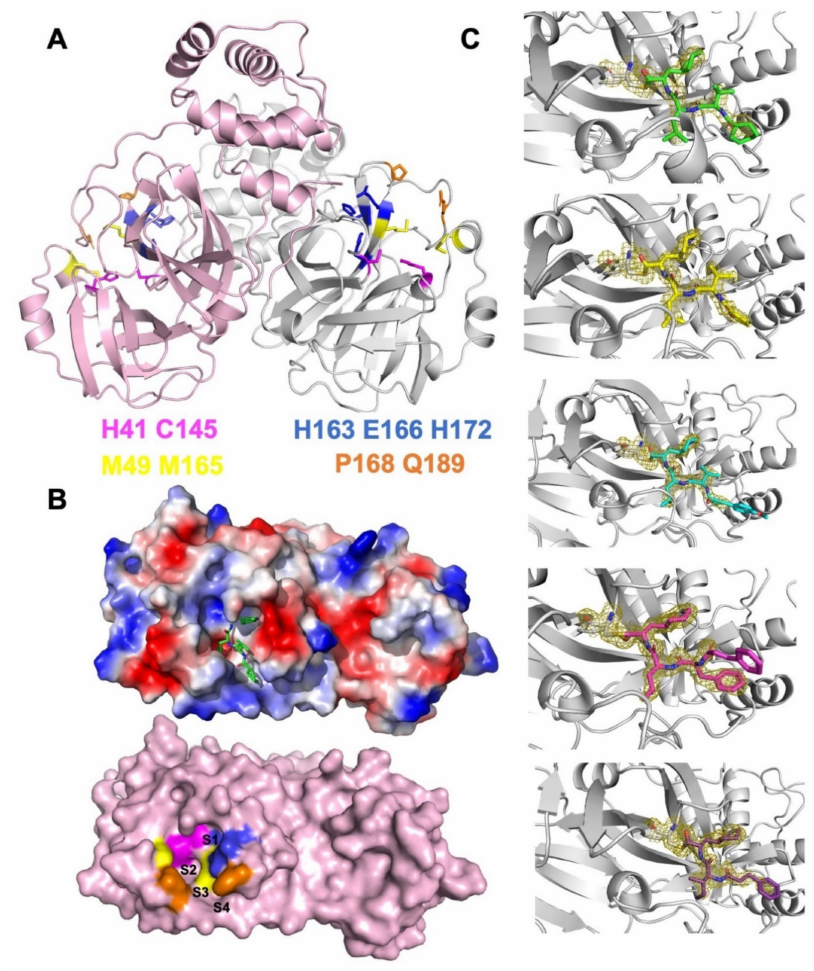
Figure 1. SARS-CoV-2 3CL Pro as a validated antiviral drug target. ( A ) Structural model of 3CL Pro with key residues at the S1–S4 pockets shown as sticks (magenta: catalytic dyad; blue: S1; yellow: S2; orange: S3 and S4). ( B ) Protein surface representation of 3CL Pro protomer. The lower panel indicates the locations of the S1, S2, S3, and S4 pockets, and the upper panel shows the electrostatic potentials (blue: positively charged; red: negatively charged) with a model of ligand fitted into the binding pocket. ( C ) The crystal structures of the designed TPMs binding to 3CL Pro via C145–formyl covalent bonds. 2Fo–Fc electron densities of each TPM ligand and the C145 residue are highlighted as meshes (contoured at 1.5 σ